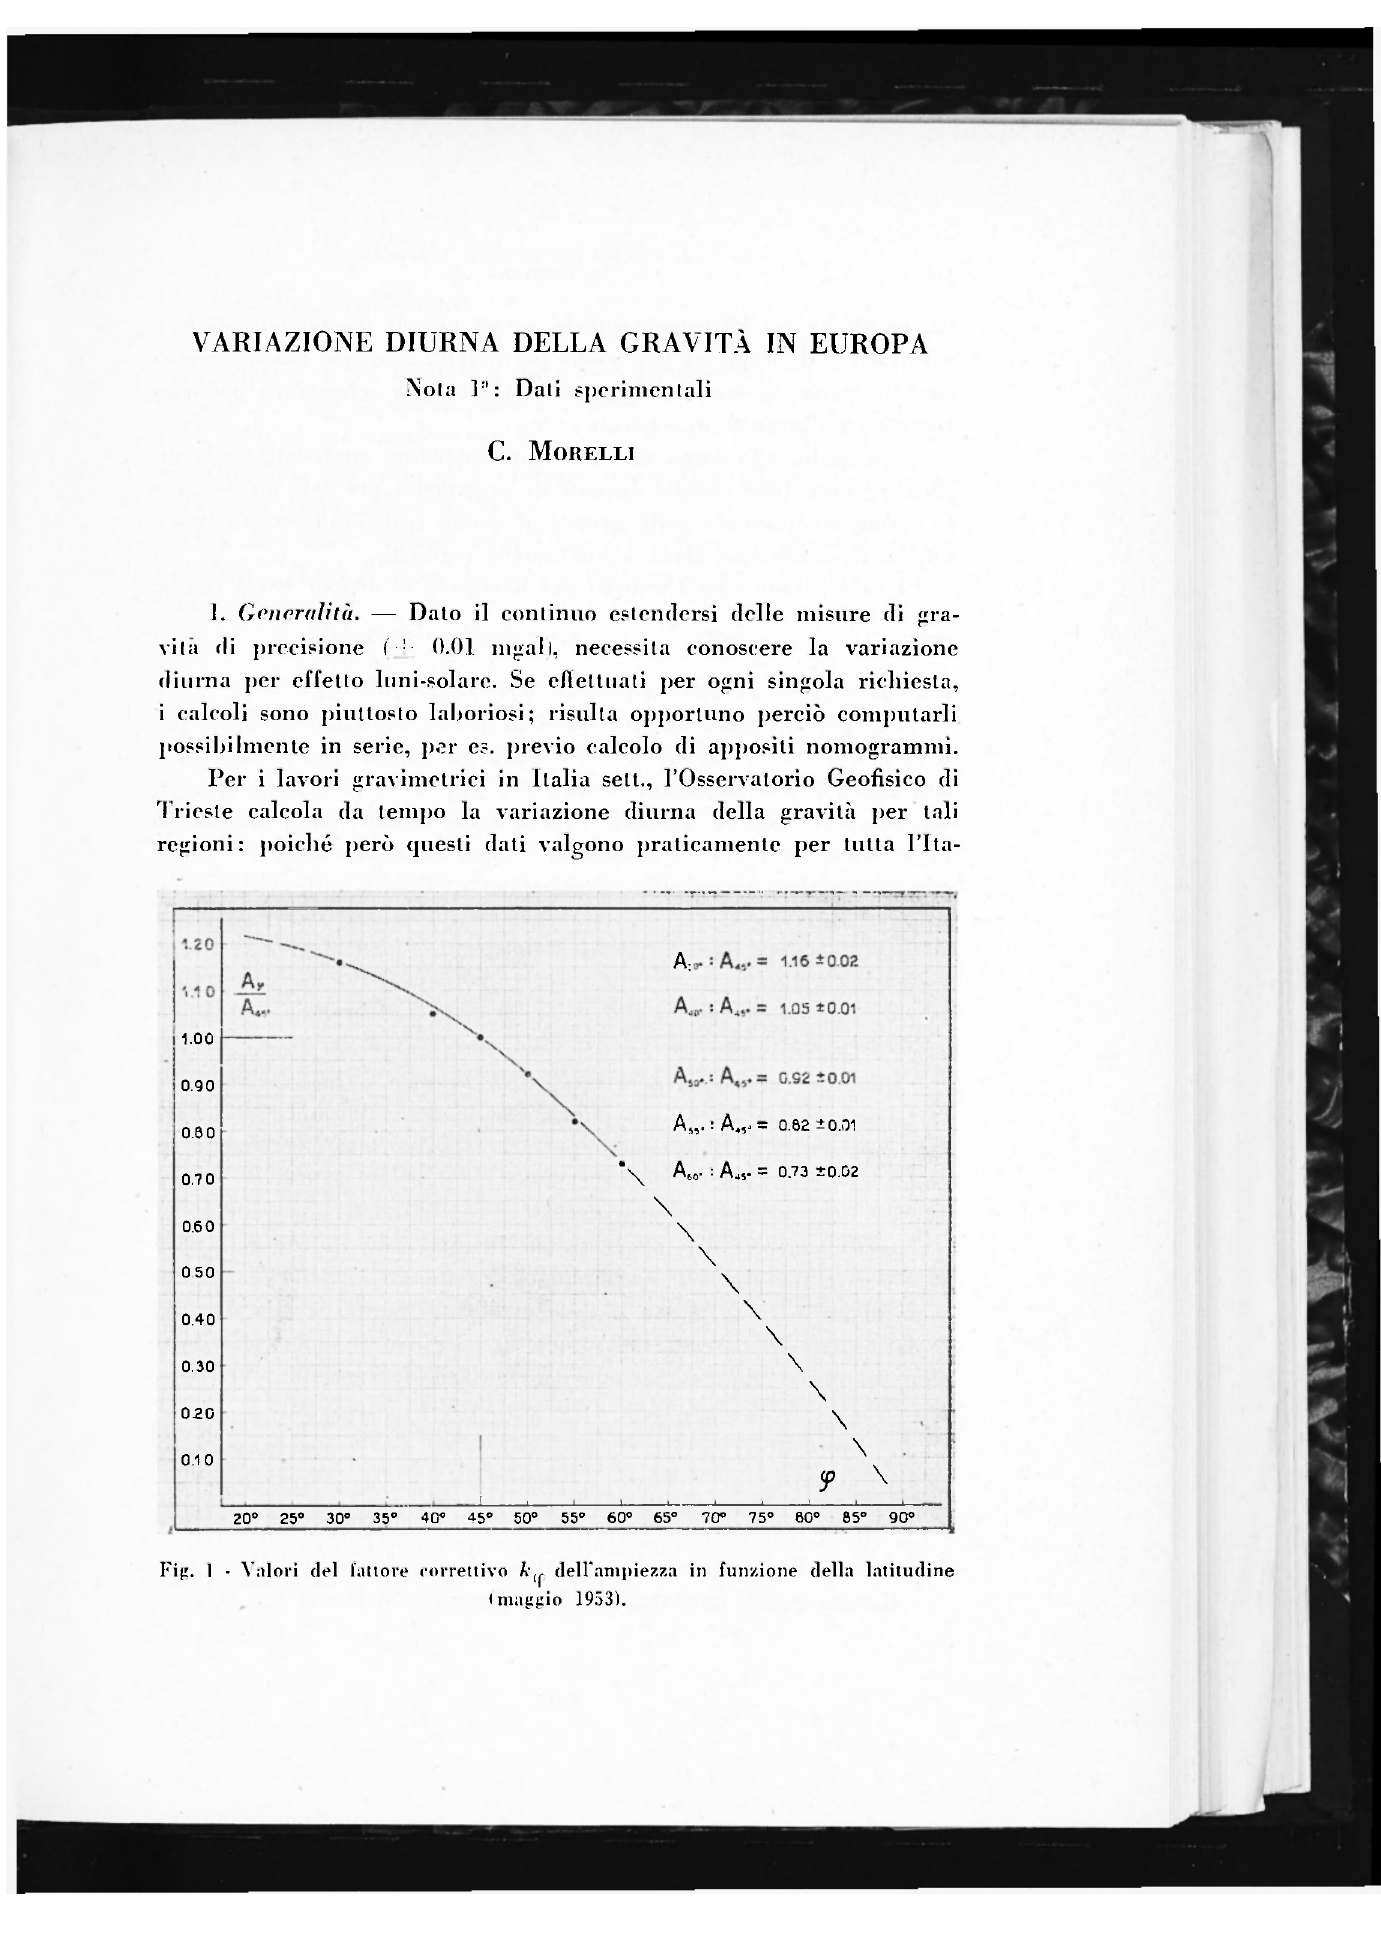
Fig. 1 - Valori del fattore correttivo k^ dell'ampiezza in funzione della latitudine (maggio